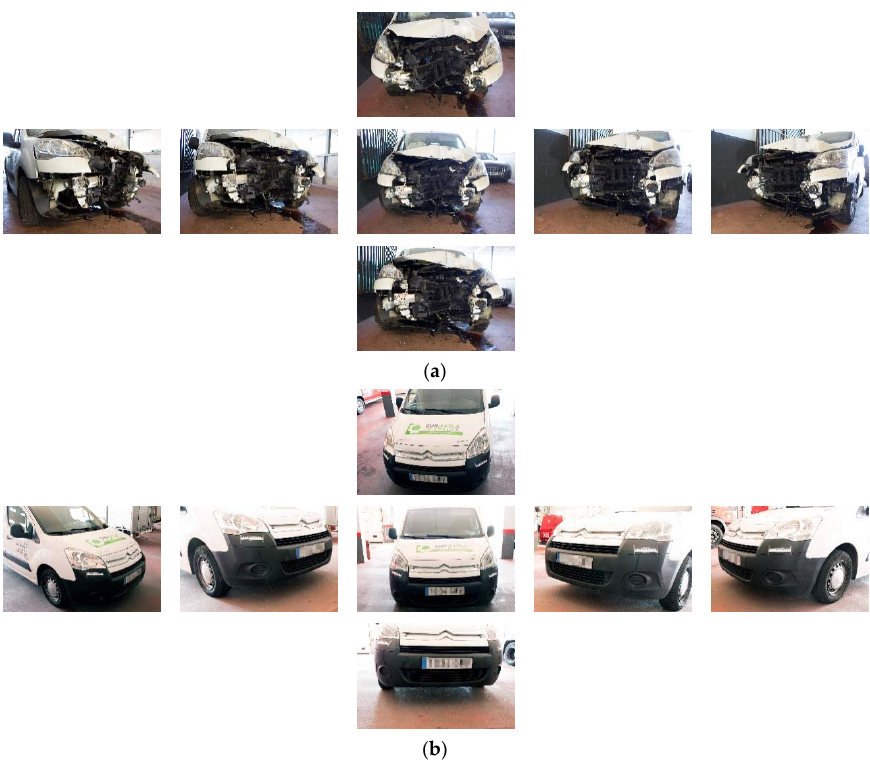
Figure 6. Data acquisition protocol used to digitalise the car’s frontal: ( a ) deformed model; and ( b ) non-deformed model. Table 2. Technical specifications of the photographic sensor and lens system used for the photogrammetric reconstruction.